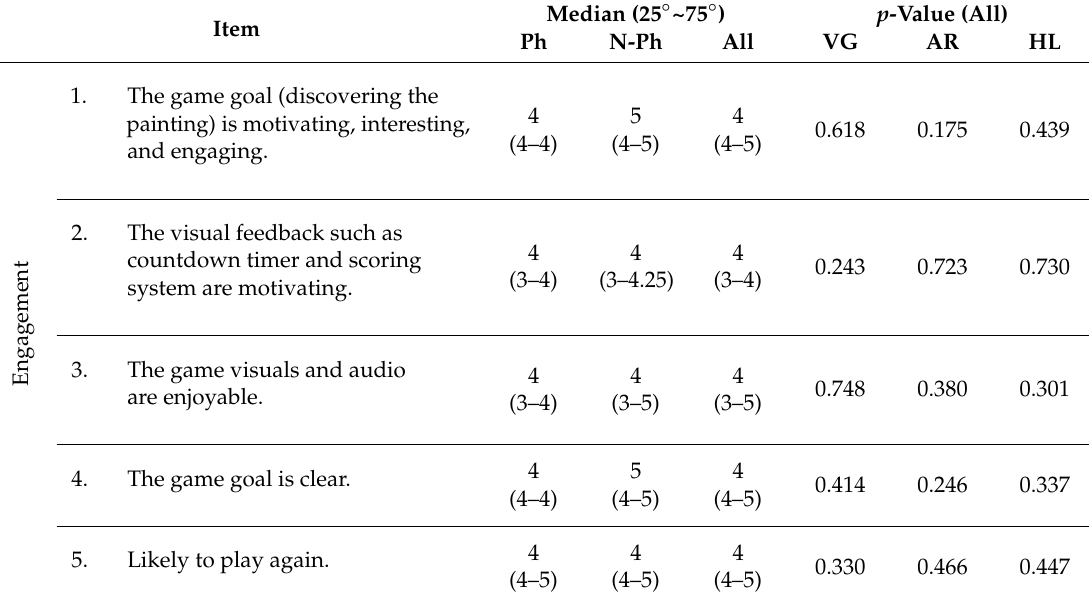
Table 3. Results of the Likert